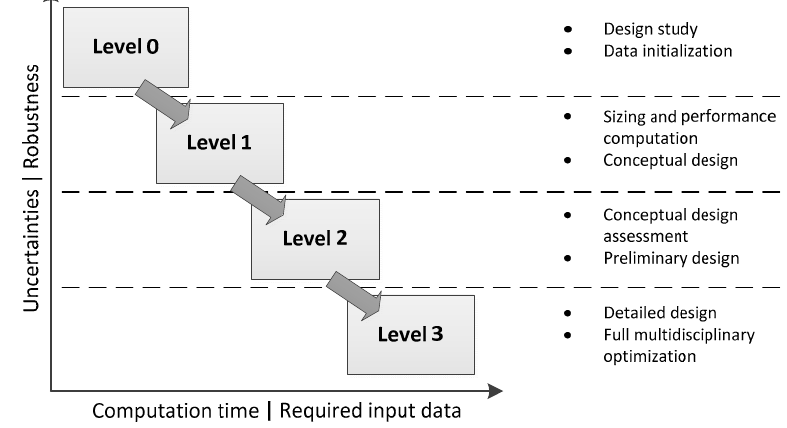
Figure 2. Classification of tools.